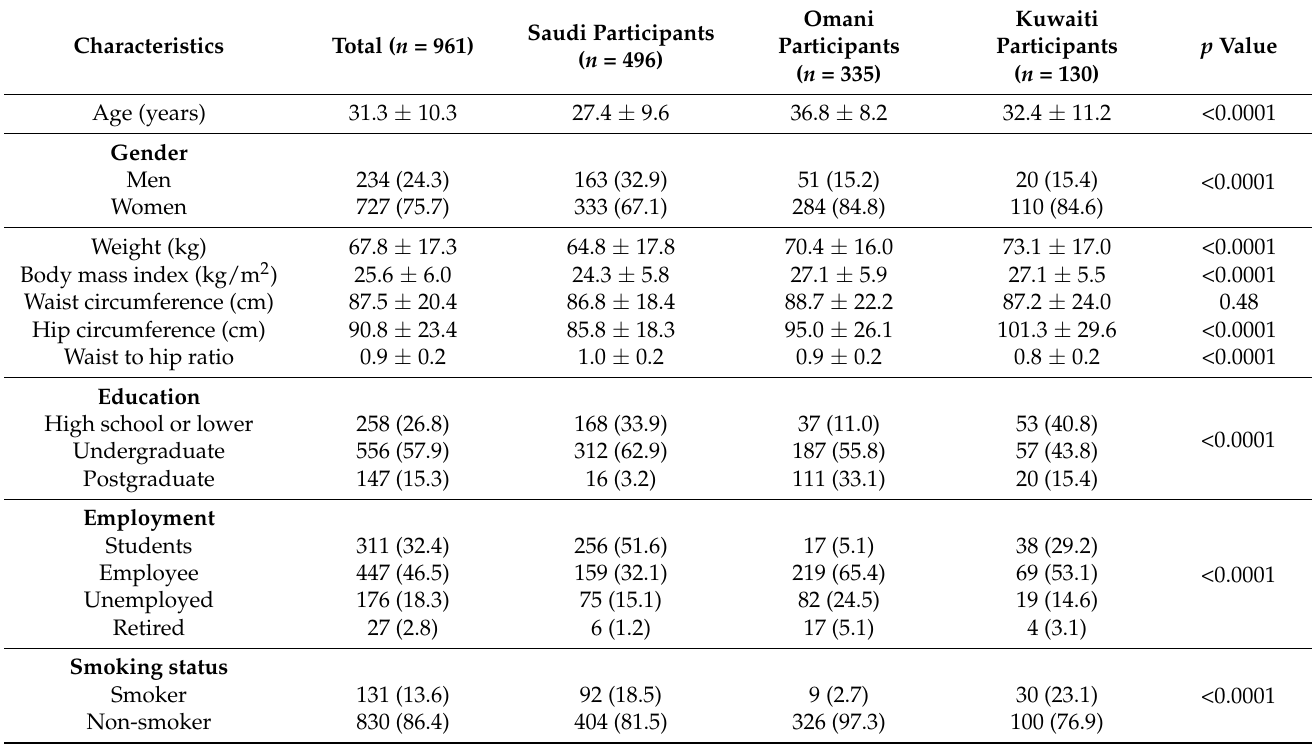
Table 1. Main characterization of study